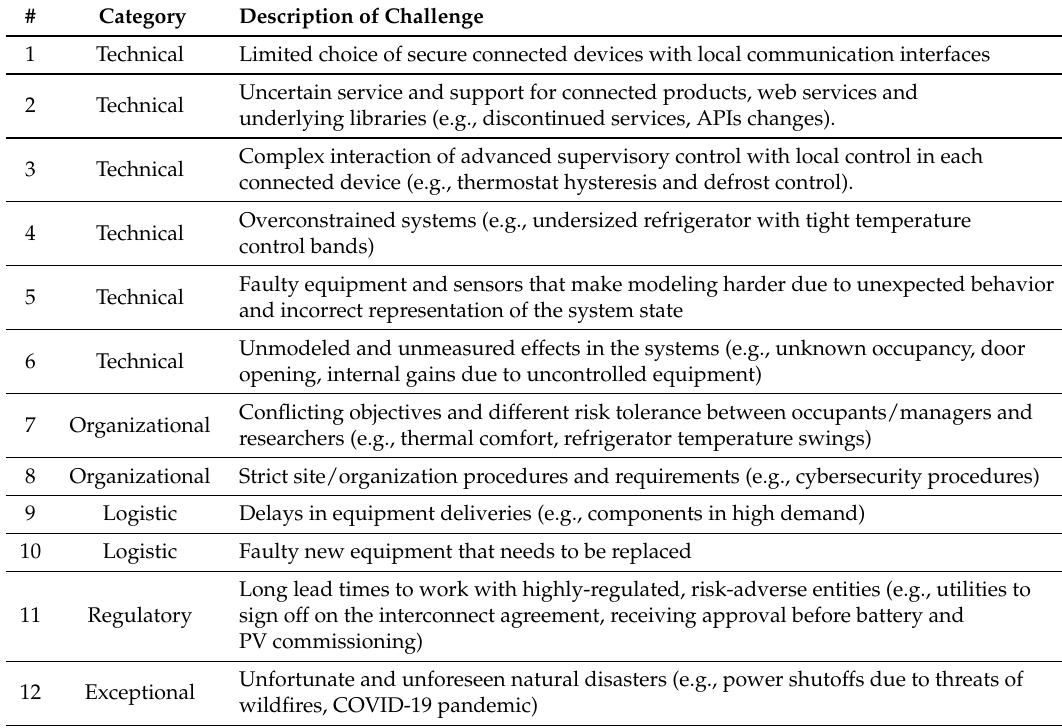
Table 5. A summary of challenges faced during the implementation and deployment of